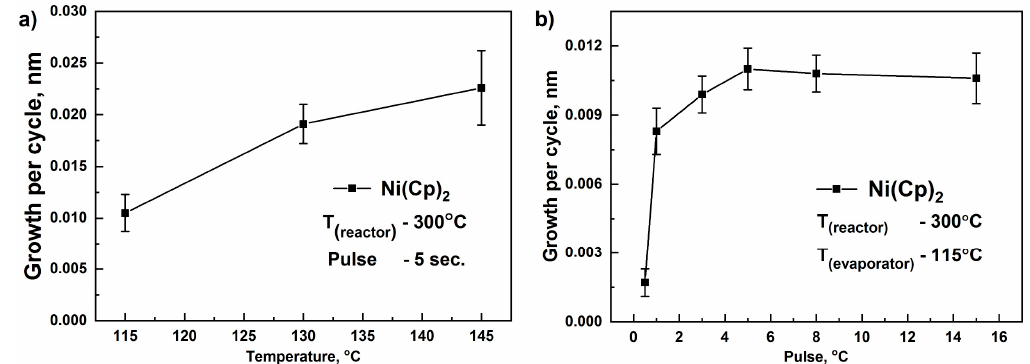
Figure 1. The change of growth per cycle (GPC) with: ( a ) an increase in the evaporation temperature of NiCp 2 ; and ( b ) pulse time. Substrate temperature was 300 ° С . Error bars indicate the thickness gradient.